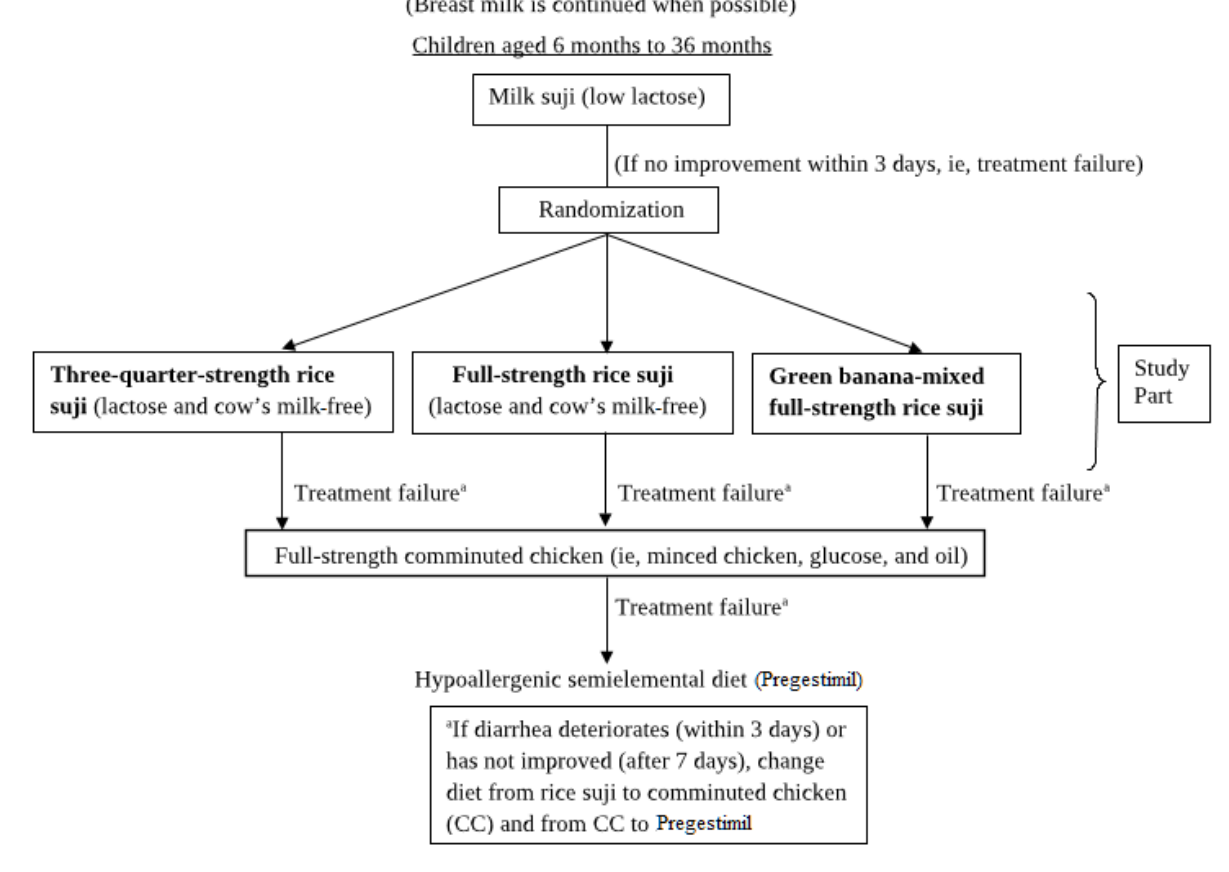
Figure 1. Flowchart for the proposed randomized controlled